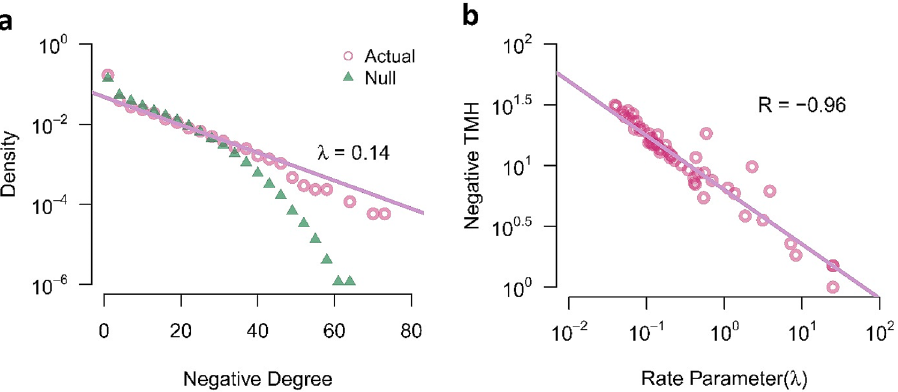
Figure 6. Collective behavior of resting-state negative functions. (a) Semi-logarithmic negative degree distribution of actual networks and null-networks. (b) A negative correlation between the logarithm of negative TMH and the logarithm of the rate parameter of negative degree distribution. Each circle corresponds to the signed network of a subject. TMH tendency to make hub, R Pearson correlation coefficient; λ rate parameter of the exponential degree distribution.